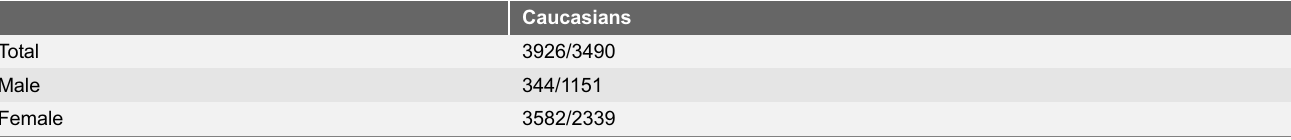
Table 1. Demographic distribution of the individuals in the study*.